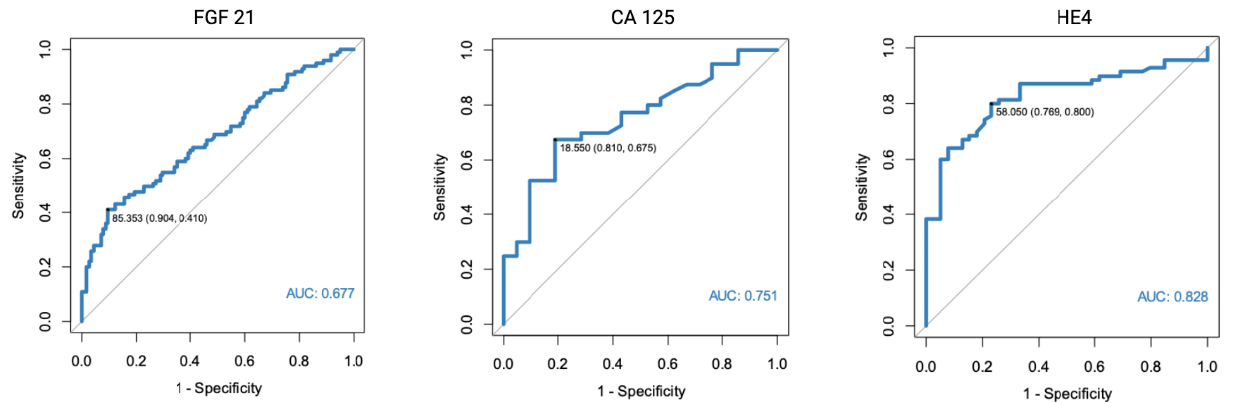
Figure 1. ROC curve analysis of FGF 21, CA 125, and HE4 performance in EC diagnostics (endometrial cancer vs. normal endometrium, polyps, and fibromas).